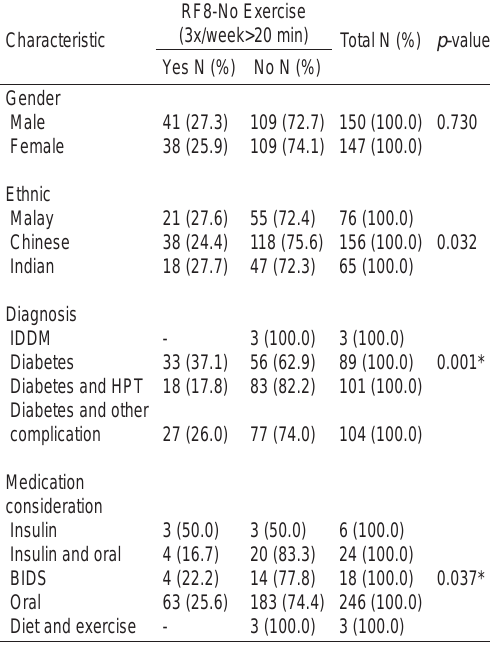
TABLE 9. Characteristic determination of RF7-Hypoglycae- mia in study population